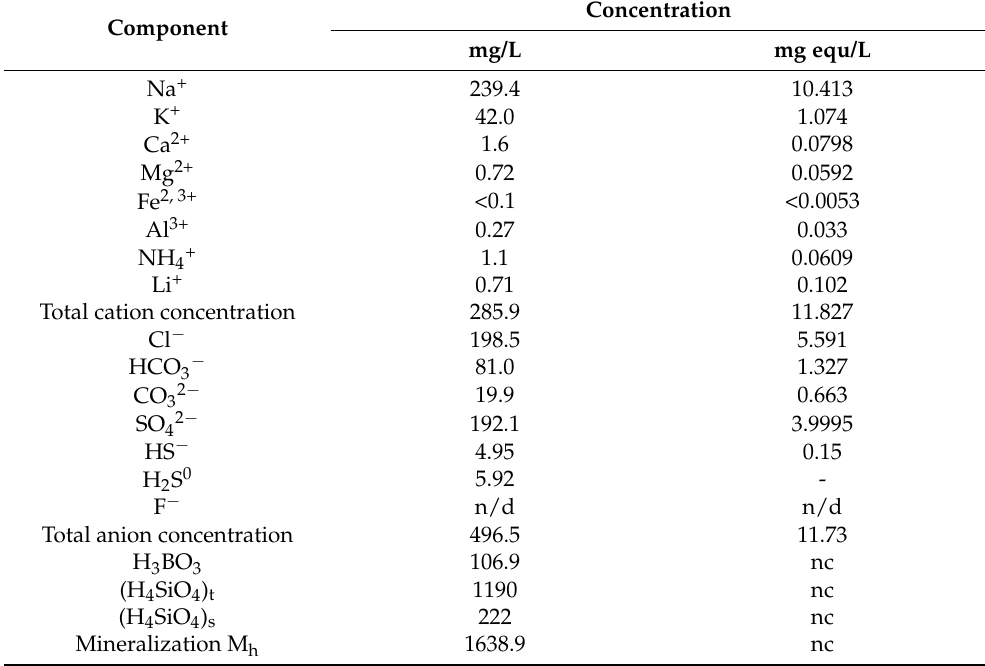
Table 1. Characteristics of the hydrothermal solution from the Mutnovsky field, ionic